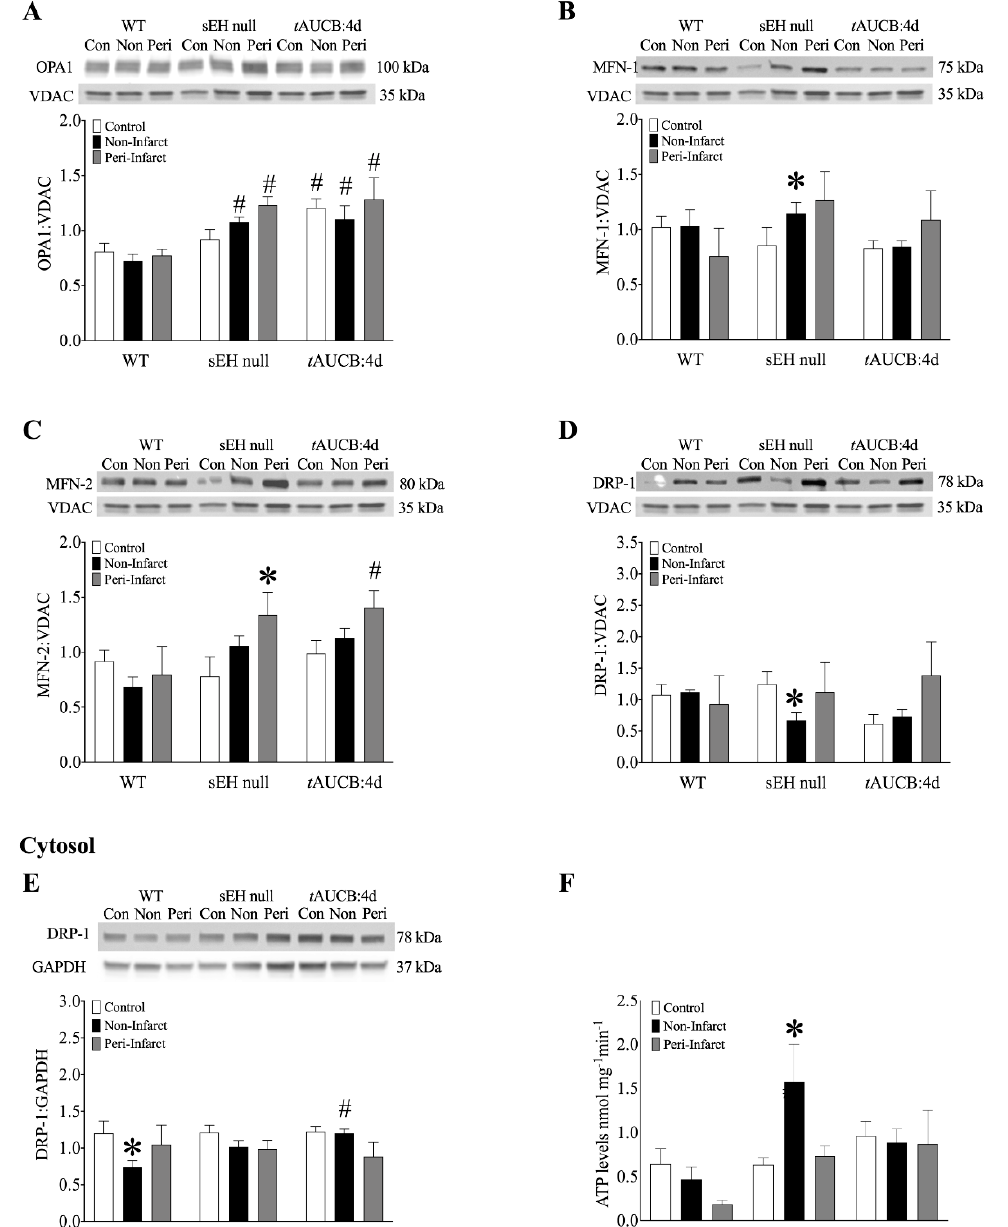
Figure 6. Protein expression in mitochondrial ( A – D ), and cytosolic ( E ) fractionates from female mouse hearts at 28 days post-MI. ( A ) OPA1, ( B ) MFN-1, ( C ) MFN-2, and ( D ) DRP-1 normalized to VDAC in isolated mitochondria in female WT, sEH null, and tAUCB:4d control, non-infarct and peri-infarct regions at 28 days post-MI. ( E ) Cytosolic DRP1 normalized to GAPDH, ( F ) ATP levels in nmol mg-1min-1 from WT, sEH null, and tAUCB:4d pre-treatment female mice in control and post-MI hearts. Data are means ± SEM, N = 3–6. p < 0.05; * vs. Control; # vs. WT group.